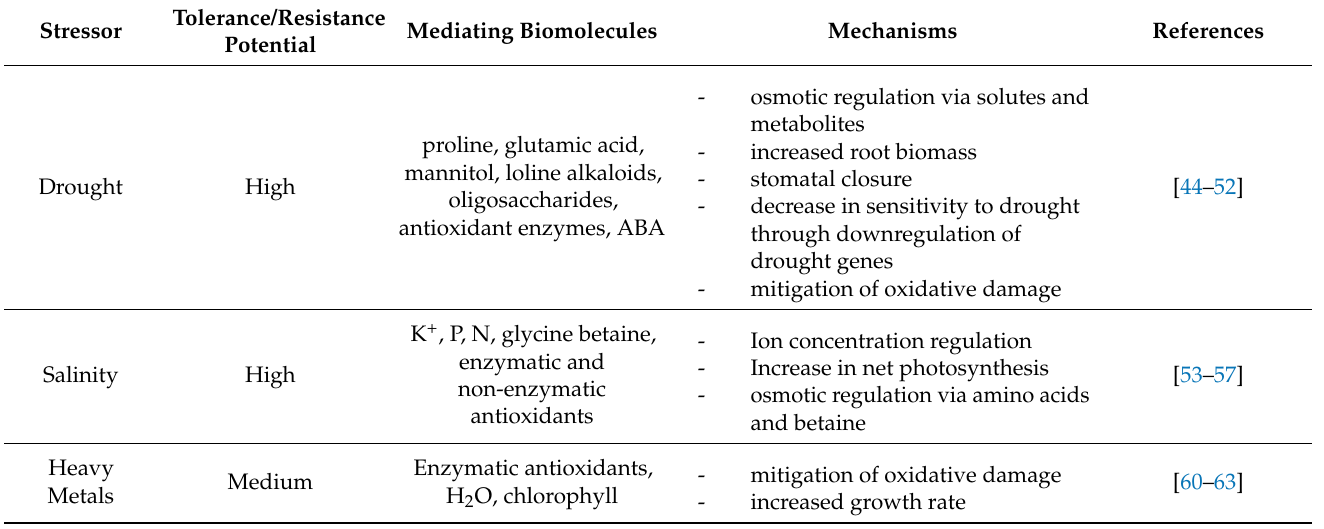
Table 1. List of biotic and abiotic stressors, the potential tolerance/resistance that Epichloë infection could provide, the mediating biomolecules involved in resistance/tolerance and the mechanisms in which Epichloë infection works to combat the